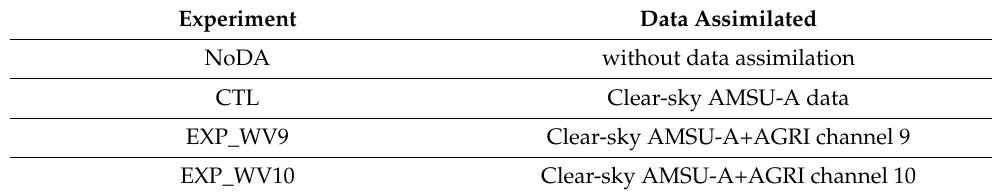
Table 3. Experimental design for each